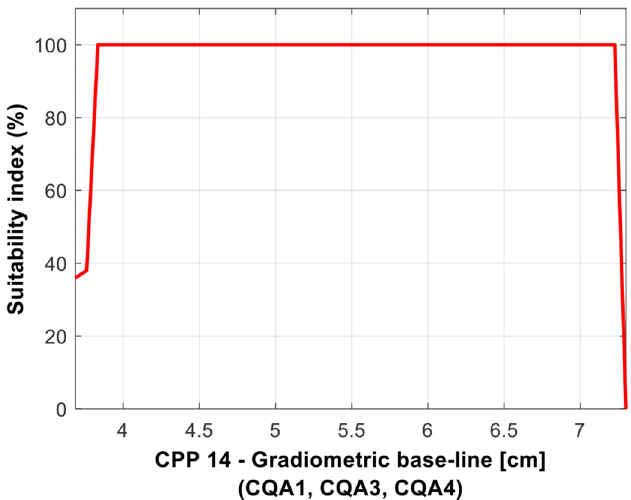
Fig. 9. Suitability index of CPP 14 according to values of baseline distance between GMI